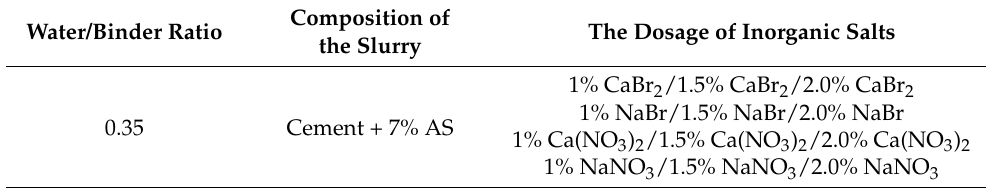
Table 5. Setting time test design proportions.